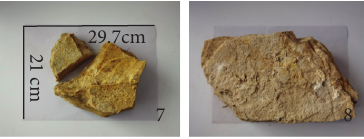
Figure 9: Rock samples of the fracture